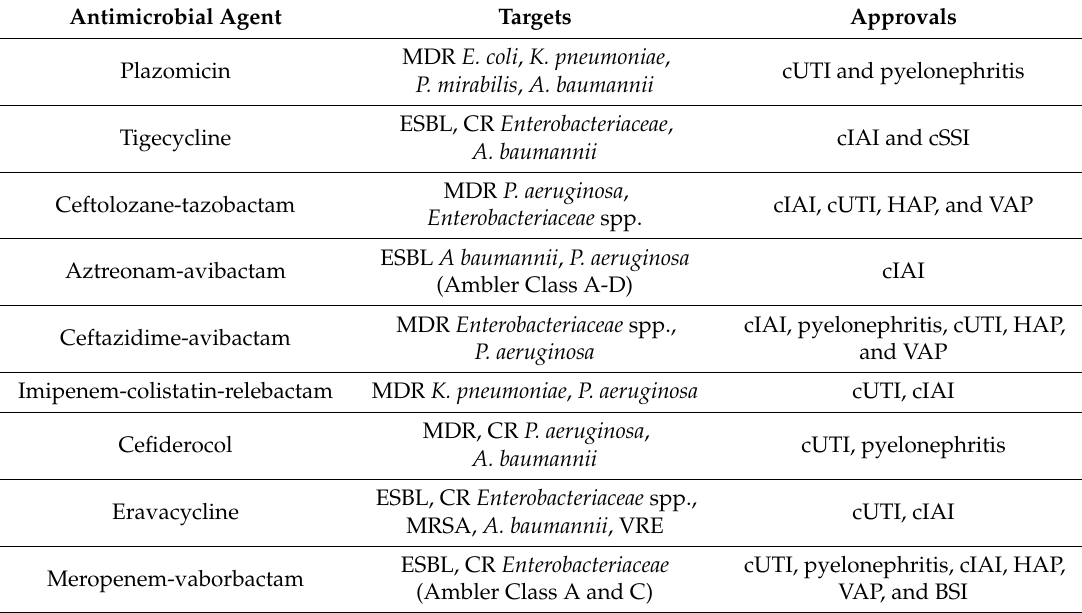
Table 2. Emerging and recently established antimicrobials in the fight against Gram-negative antibiotic resistance. MDR, multi-drug